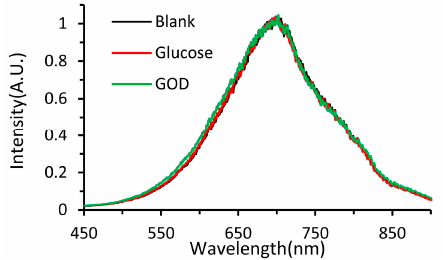
Figure A2. SPR extinction spectra of Ag nanoprisms in presence of glucose or GOD.